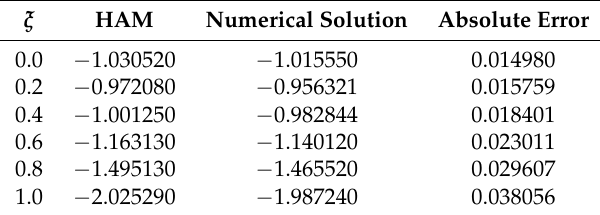
Table 4. Comparision of HAM and Numerical results for f ( ξ ) .